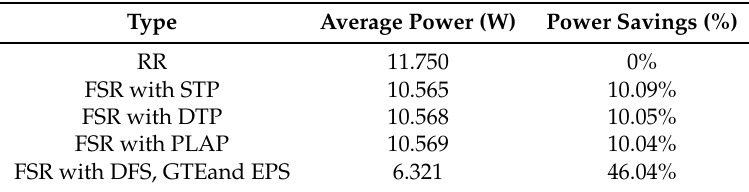
Table 6. Average power consumption for the day. DFS, dynamic frequency